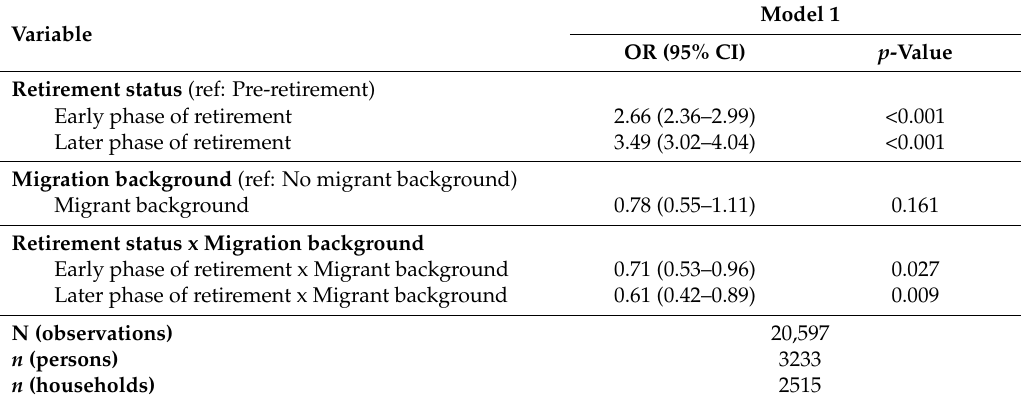
Table 2. Estimates from the mixed-effects logistic regression model on sports participation by migration